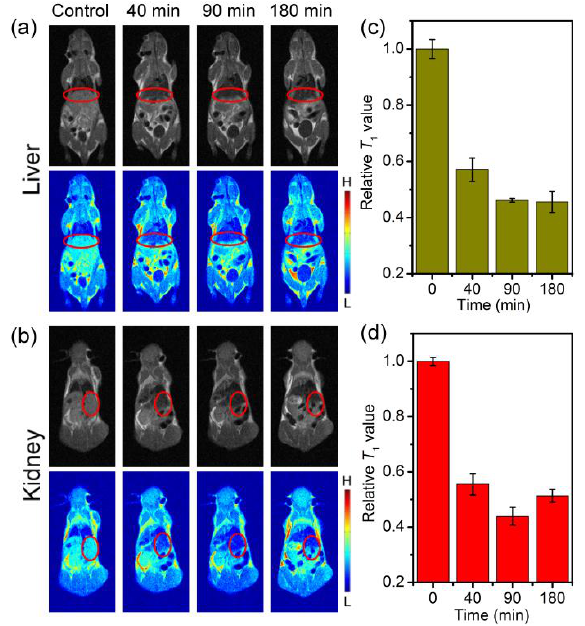
Figure 5. In vivo T 1 -weighted magnetic resonance (MR) images of mice ( a ) liver and ( b ) kidney (selected area) collected before (control group) and after intravenous injection of Fe 3 O 4 -BSA nanoparticles at different time points, and the corresponding relative T 1 -weighted signals extracted from ( c ) liver and ( d ) kidney